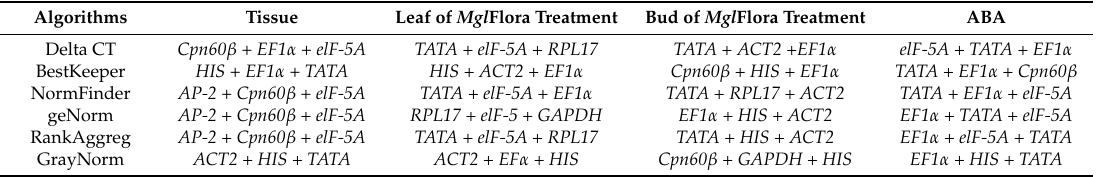
Figure 6. Rank aggregation of 14 candidate reference genes in four sample sets. The RankAggreg package is loaded in the R program. Ranking lists of ∆ Ct, BestKeeper, NormFinder and geNorm are shown as gray lines. The red line indicates the result based on the Monte Carlo algorithm, while the mean rank of each gene of each method is represented in black. Abbreviations: ABA: Abscisic Acid treatment. Table 6. Best combinations of reference genes based on ∆ Ct, BestKeeper, Normfinder, geNorm, RankAggreg or GrayNorm in different tissues and different hormone treatments.